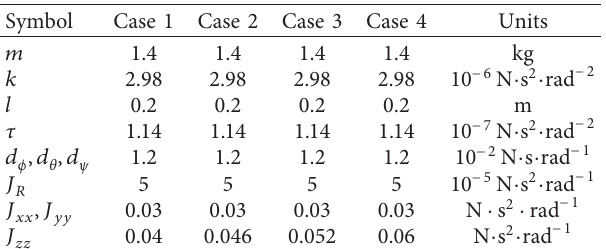
Figure 4: The experimental system architecture. Table 3: Quadrotor parameters.